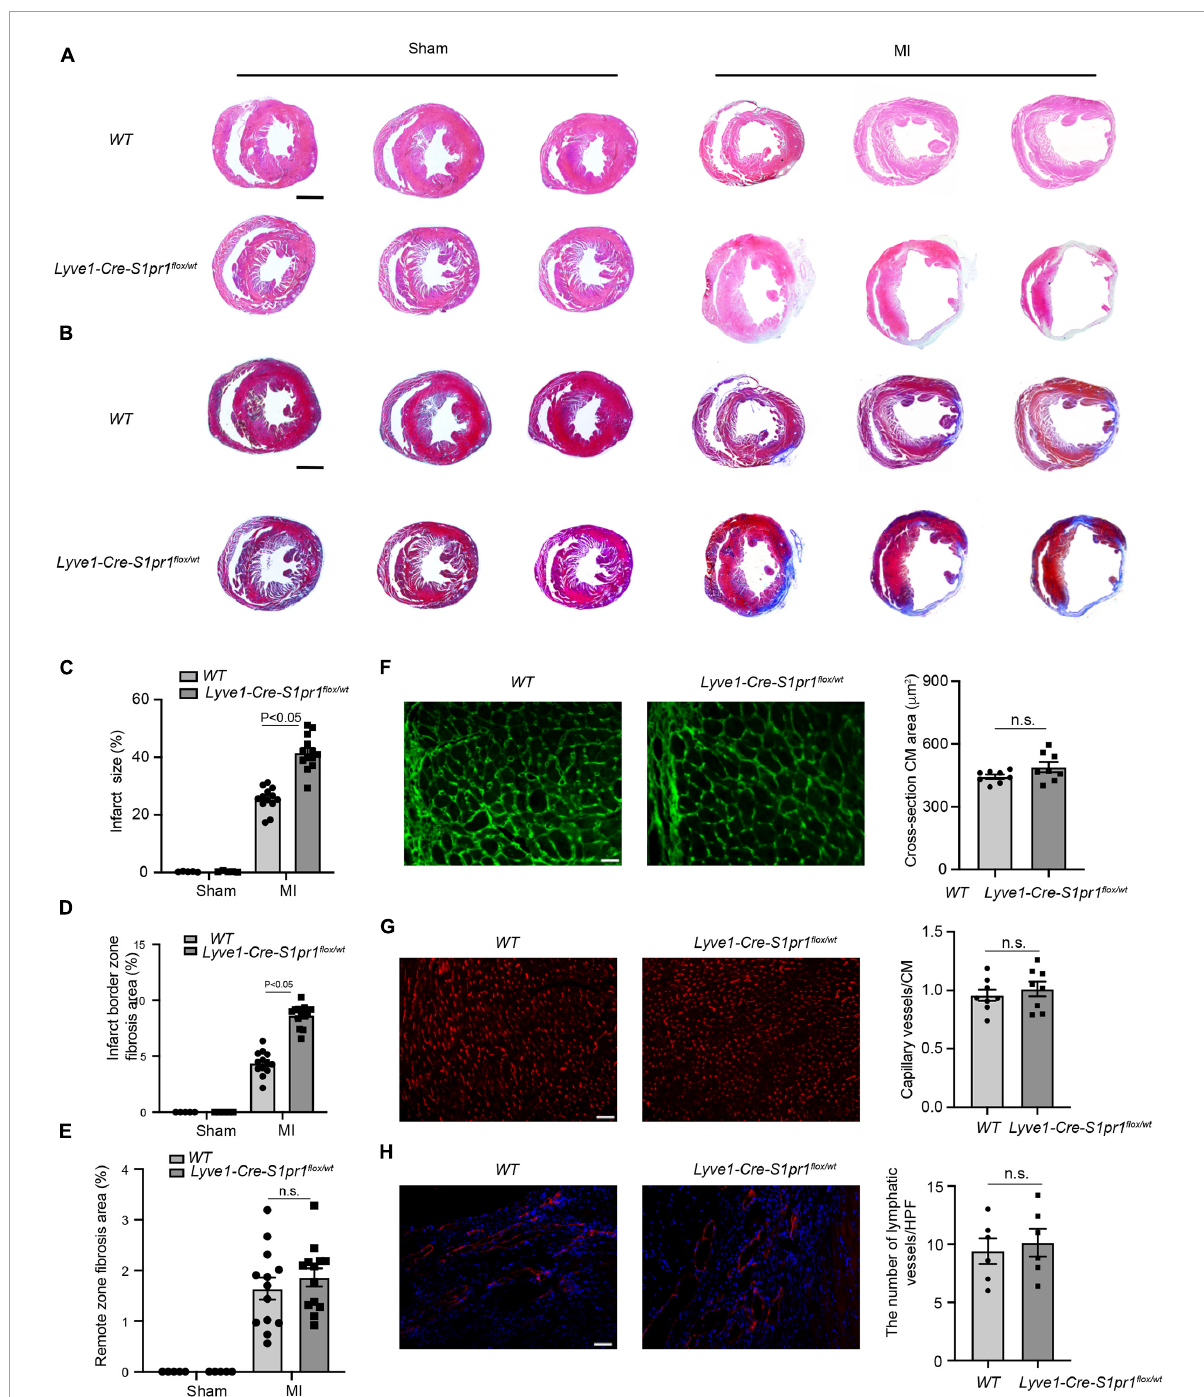
FIGURE3 The reduced expression of LEC-S1pr1 aggravates post-MI pathological cardiac remodeling. (A) Representative images of H&E staining of serial sections from hearts in WT and Lyve1-Cre-S1pr1 flox / wt mice at 28 days after MI ( n = 13). (B–E) Representative images of Masson’s Trichrome staining of serial sections from hearts in WT and Lyve1-Cre-S1pr1 flox / wt mice at 28 days after MI ( B ), with quantification of the percentage of infarct size and cardiac fibrosis in left ventricle myocardium ( C–E ) ( n = 13). (F) Representative images of WGA staining of hearts in WT and Lyve1-Cre-S1pr1 flox / wt mice at 28 days after MI, with quantification of the cross-section cardiomyocyte area in hearts ( n = 8). (G) Representative images of isolectin-B4 staining of hearts in WT and Lyve1-Cre-S1pr1 flox / wt mice at 28 days after MI, with quantification of capillary density in post-MI myocardium ( n = 8). (H) Representative images of Lyve-1 (LEC marker) staining of hearts in WT and Lyve1-Cre-S1pr1 flox / wt mice at 28 days after MI, with quantification of capillary l ymphatic density in post-MI myocardium ( n = 6). Data are mean ± S.E.M. Scale Bars: (A,B) , 2 mm; (F–H) , 50 µ m; n.s., no statistical